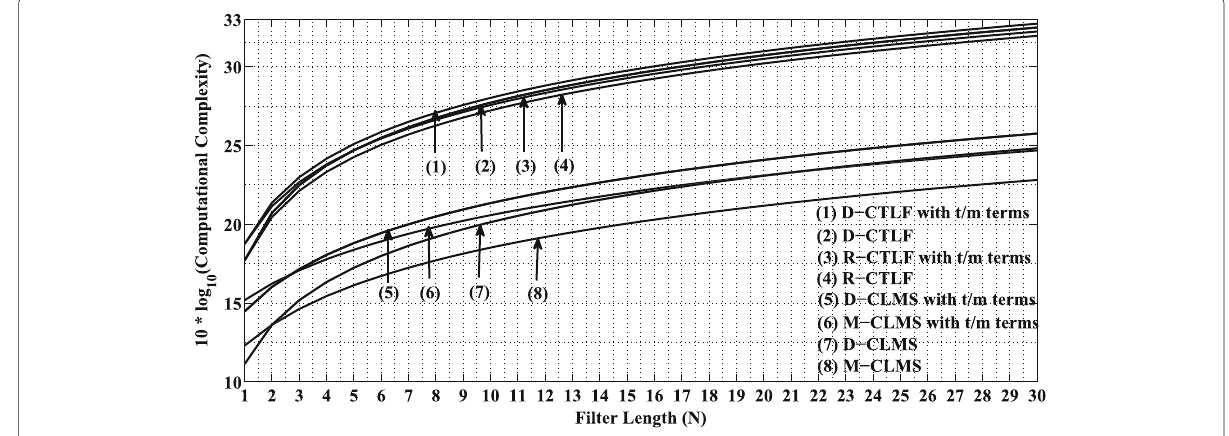
Fig. 6 Computational complexity comparison for M =